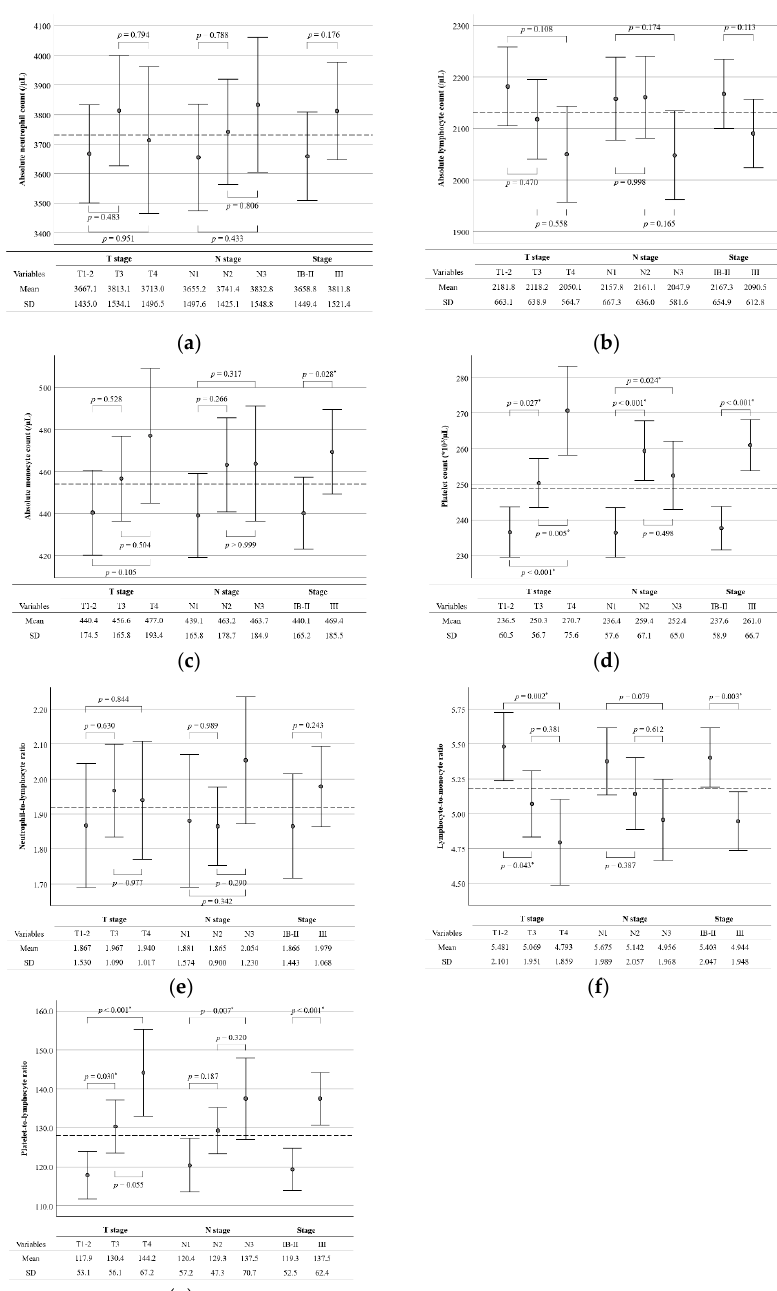
Figure 1. Error bar plots comparing preoperative blood cell counts and their ratios according to tumor stage: ( a ) absolute neutrophil count; ( b ) absolute lymphocyte count; ( c ) absolute monocyte count; ( d ) platelet count; ( e ) neutrophil-to-lymphocyte ratio; ( f ) lymphocyte-to-monocyte ratio; ( g ) platelet-to-lymphocyte ratio. Asterisks (*) indicate p < 0.005. The dashed line indicates the mean value from all patients ( n = 692). Circles and lines indicate the mean values and 95% confidence intervals in each subgroup, respectively. SD, standard deviation.